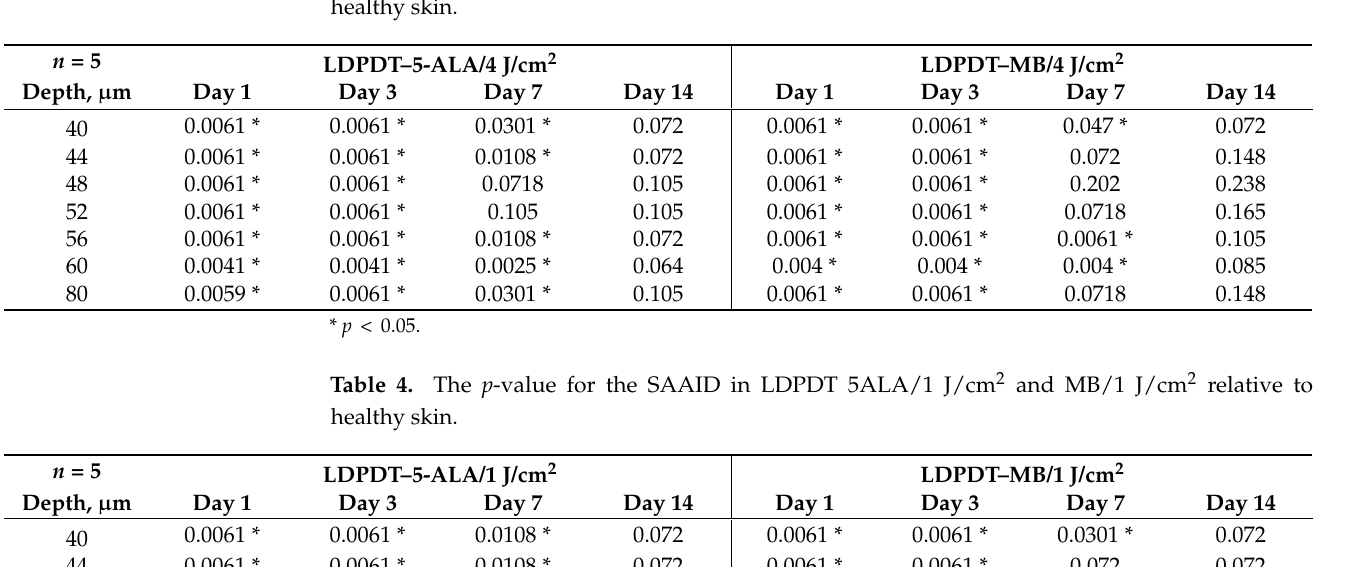
Table 3. The p -value for the SAAID in LDPDT–5-ALA/4 J/cm 2 and MB/4 J/cm 2 relative to healthy skin.